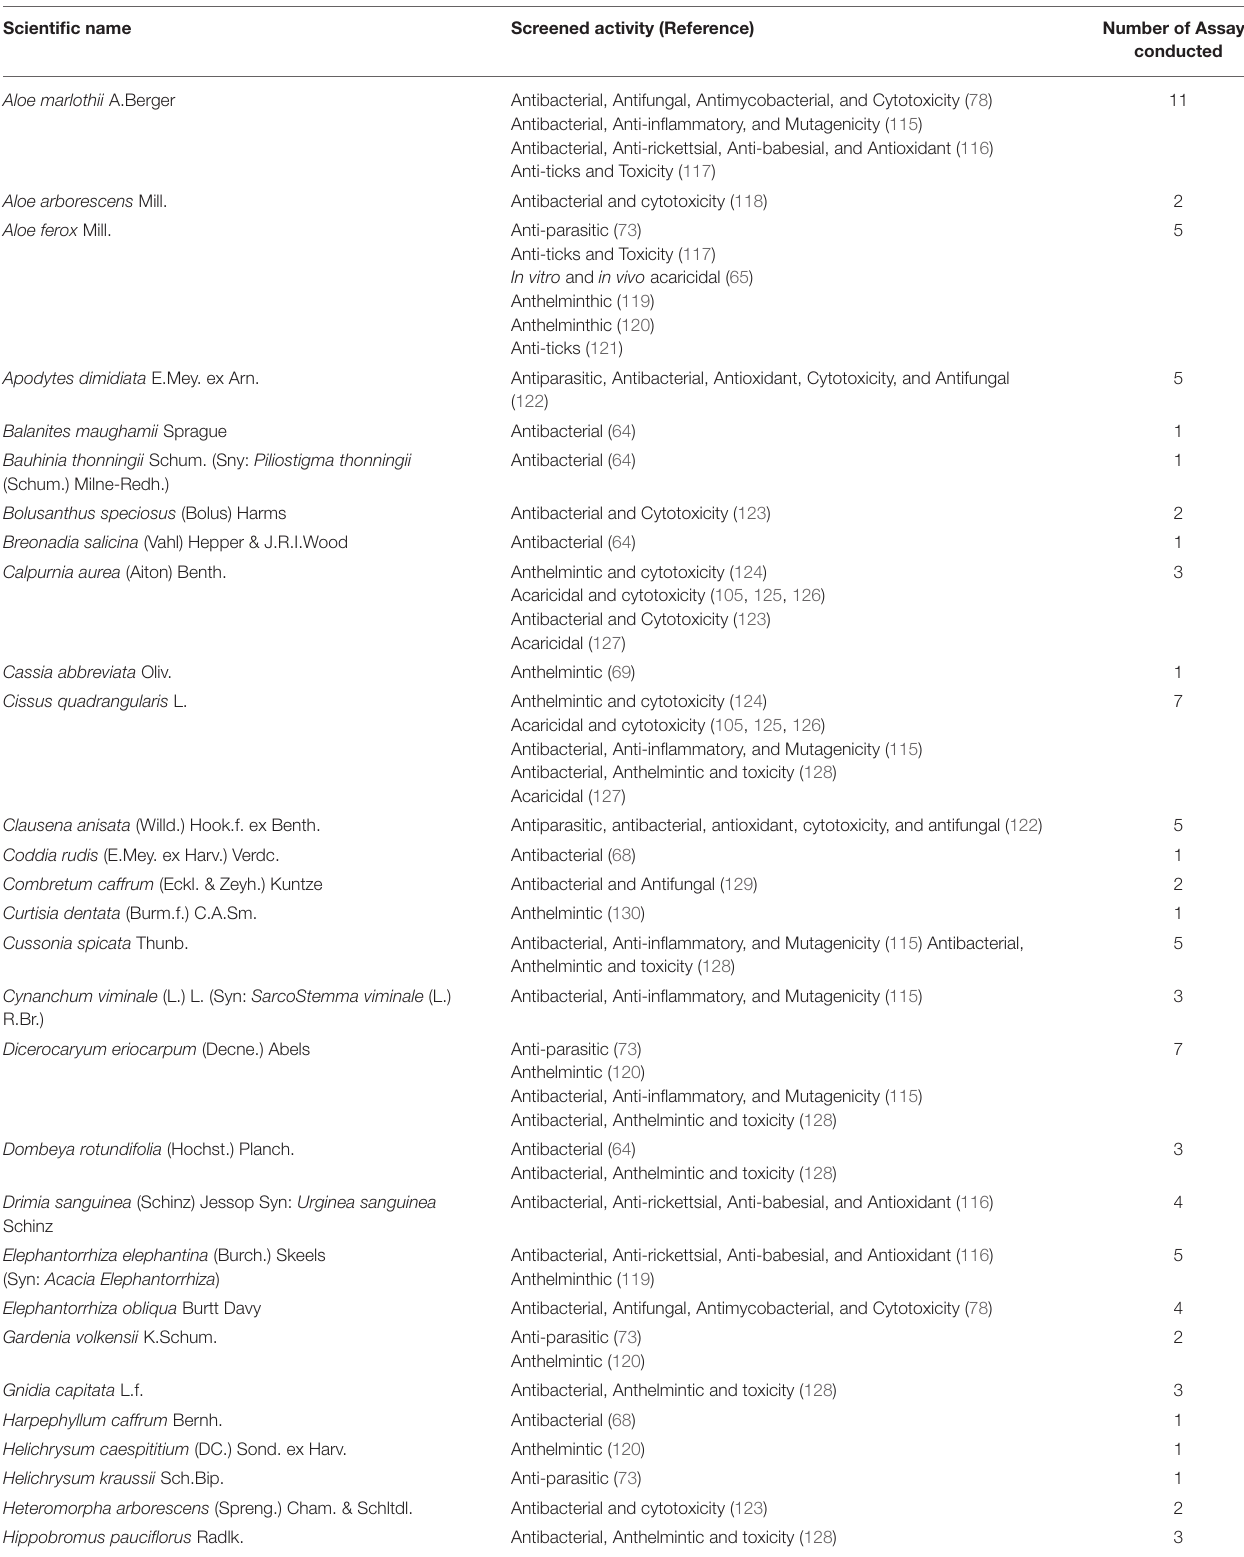
TABLE 3 | Overview of the biological evaluation of plants used to manage cattle diseases in South